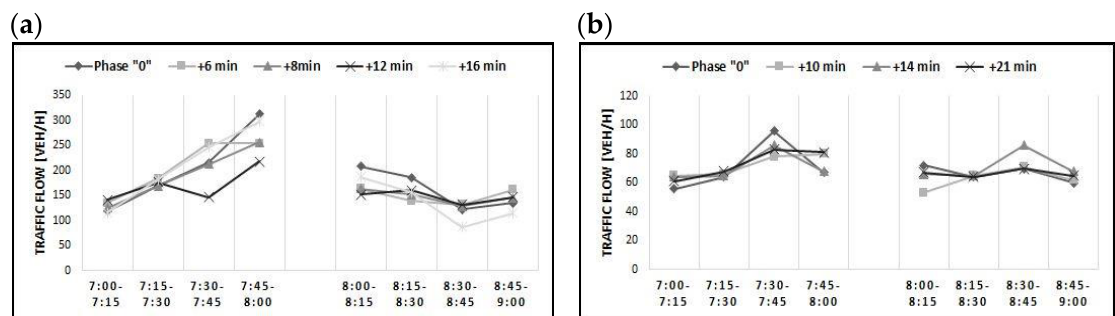
Figure 8. Samples of traffic flow changes in 15 min intervals on alternative directions ( a ) Antoniukowska Str. ( b ) Sikorskiego Str.